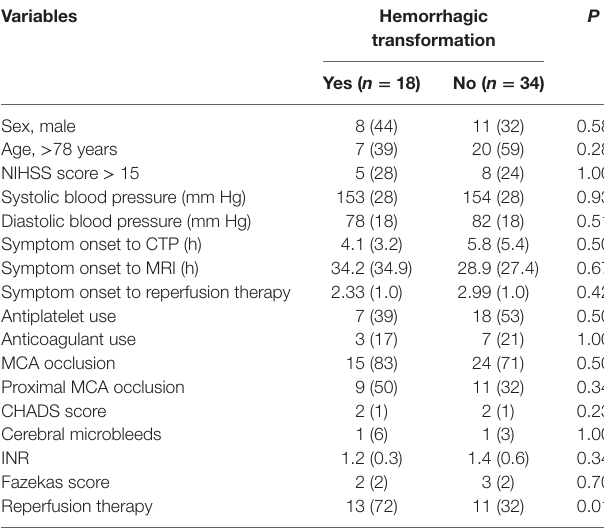
Table 1 | Demographic and clinical variables.